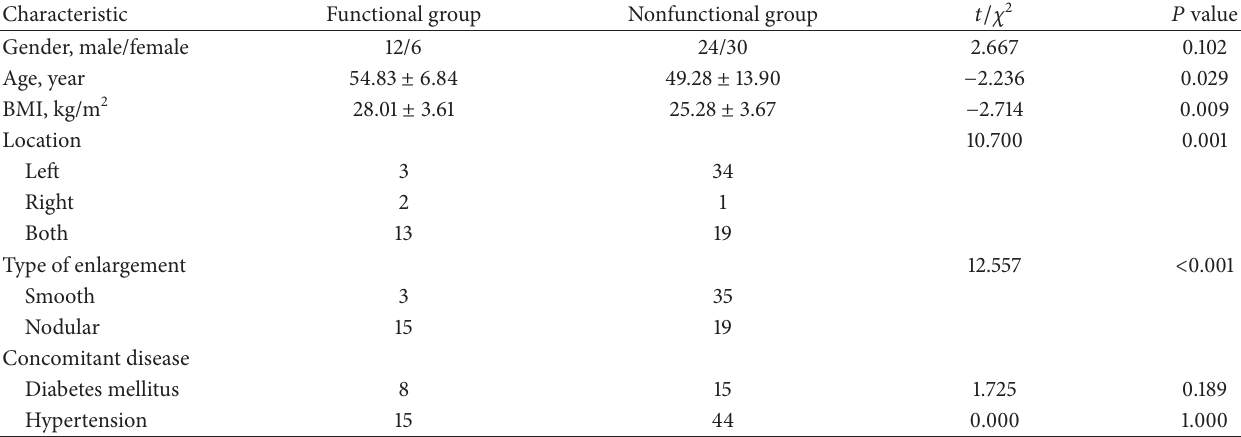
Table 2: Comparison of clinical characteristics of functional and nonfunctional lesions.